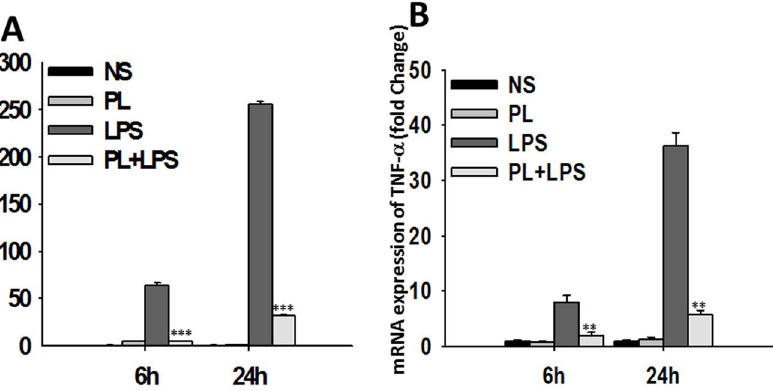
Figure 4. PL inhibits LPS-induced mRNA expression of IL-6 and TNF- a . BMDMs were pulsed with medium alone or PL, LPS, PL + LPS for 30 min, 2 h, 6 h, or 24 h. RNA was isolated and reversed transcribed to cDNA by using random primers. Levels of IL-6, TNF- a and housekeeping gene 18 S in these samples were measured by Real Time PCR analysis as described using SYBR green as the detection dye. IL-6 and TNF- a mRNA levels were normalized to the mRNA level of the housekeeping gene 18 S in the same sample. Fold change in mRNA expression of IL-6 (A) and TNF- a (B) after 6 h and 24 h stimulation over their respective baseline control level in unstimulated samples were expressed in arbitrary units. Data shown are representative of three independent experiments. Significant differences were measured by Student’s t test and are denoted by asterisks (**, P , 0.01 and ***, P , 0.001).